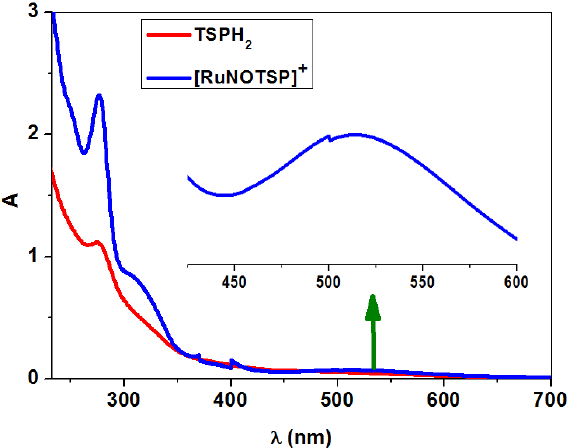
Figure 7. UV–vis absorption spectra of [RuNOTSP] + and TSPH 2 in methanol.